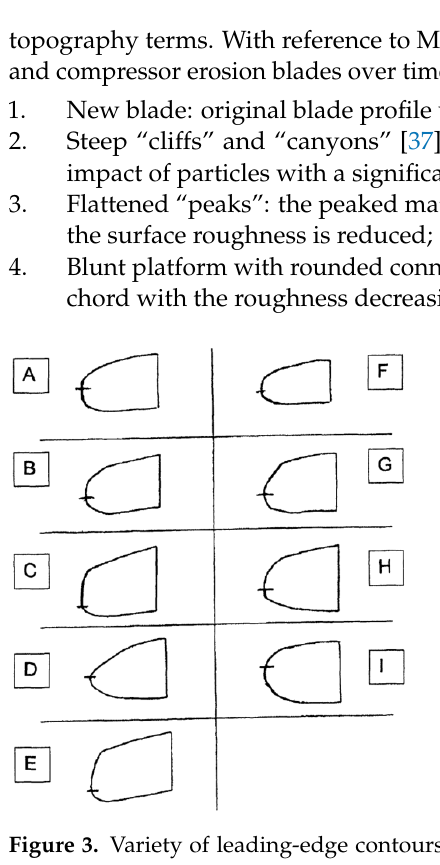
Figure 3. Variety of leading-edge contours of worn airfoils. Adapted with permission from [32], Copyright Hindawi Publishing Corporation, 2001.